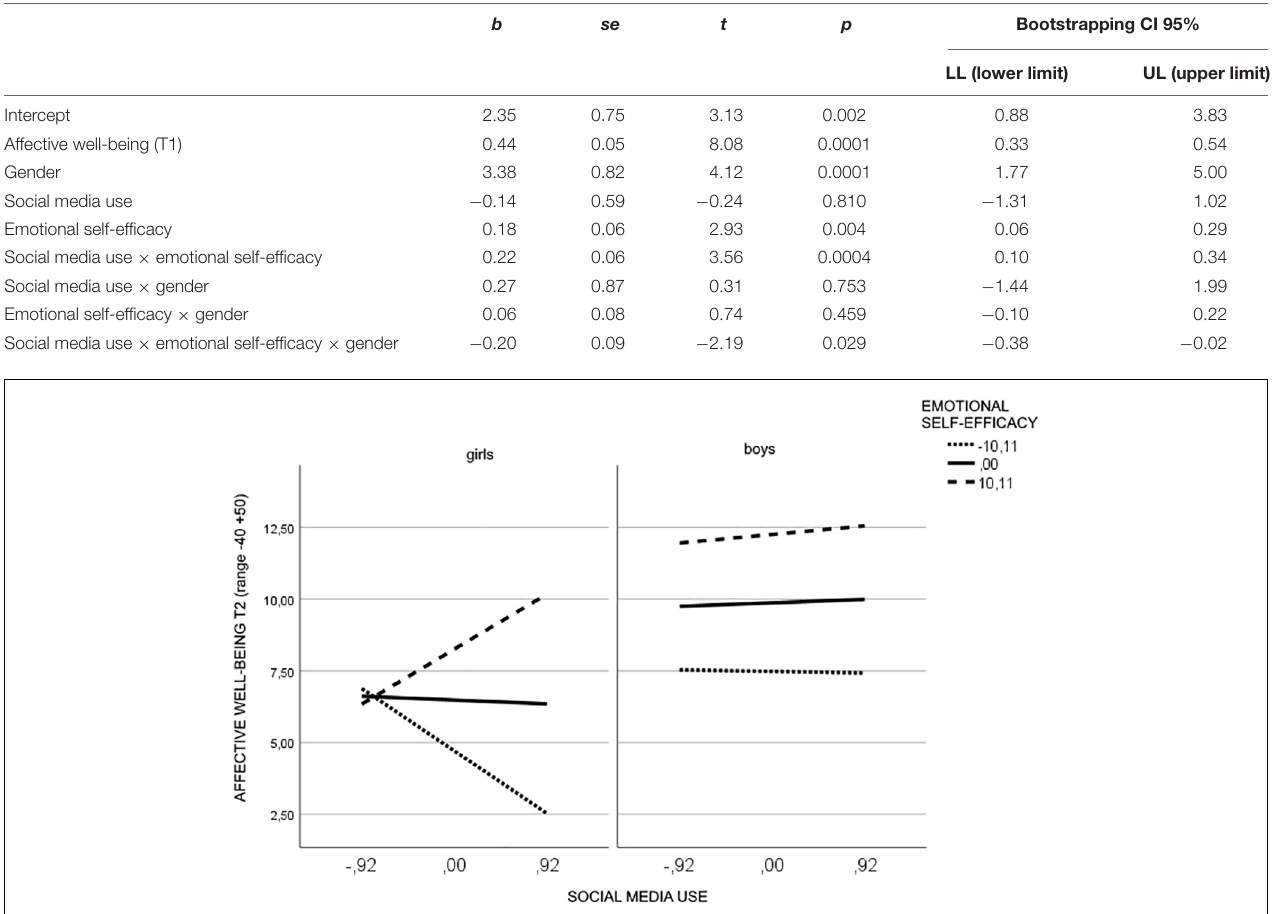
FIGURE 3 | Moderating effect of emotional self-efficacy and gender in the relationship between social media use and affective well-being.